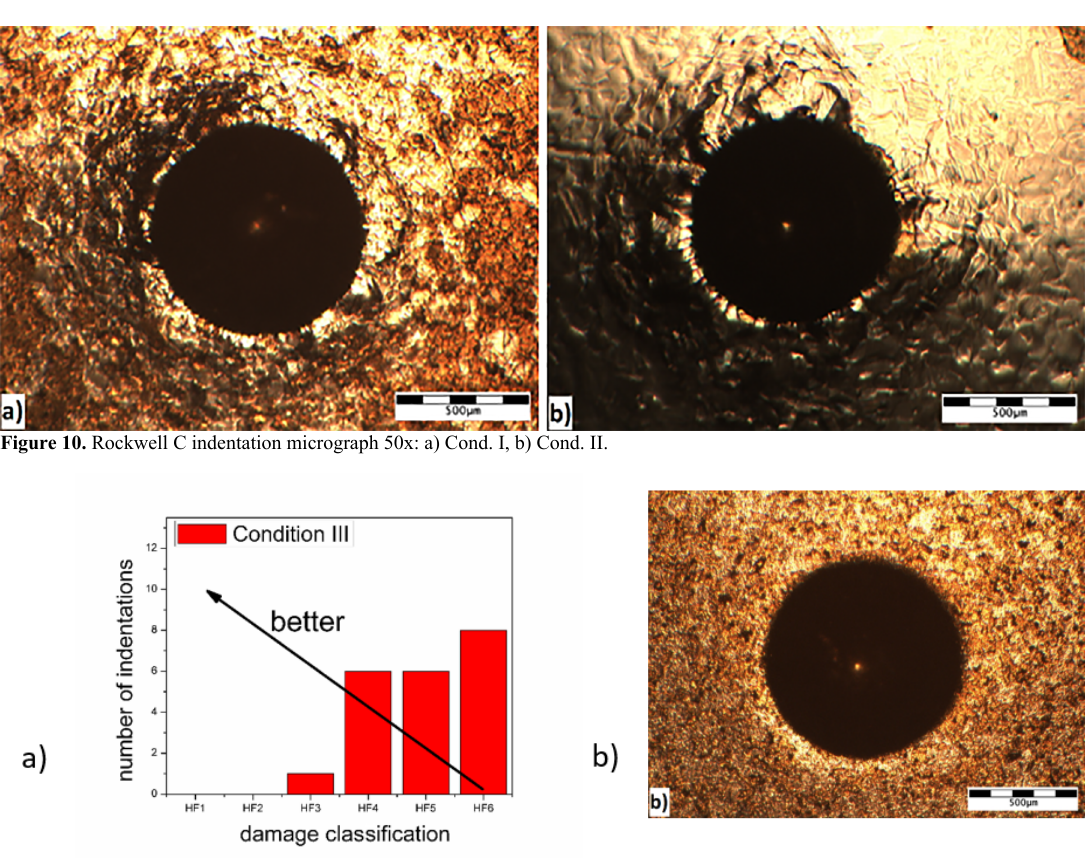
Figure 11. RC Indentation Condition III: a) Graphic, b) Micrograph